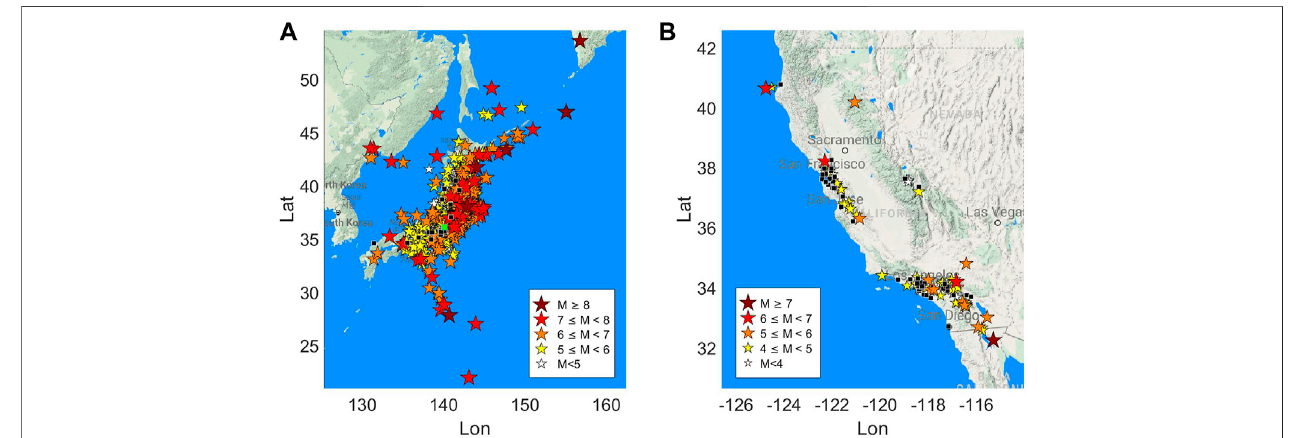
FIGURE1| Mapofthedatasetusedinthestudy.Thestarsindicatetheevents, thecolorandthesizerefertothemagnitude followingthelegendsinthe fi gure.The black squares indicate the buildings, the green one in fi gure a) is the ANX building.